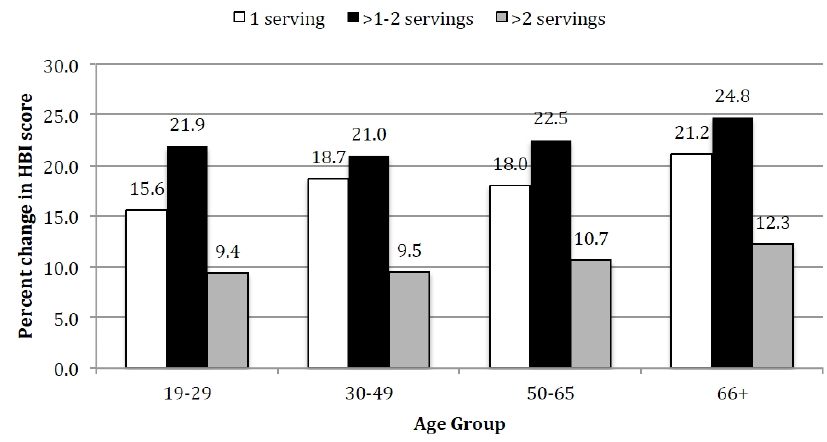
Figure 1. Predicted percent change in HBI score among adults across levels of SSB consumption as a result of replacing one serving of SSB with one serving of water. HBI = Healthy Beverage Index; SSB = Sugar Sweetened Beverages.